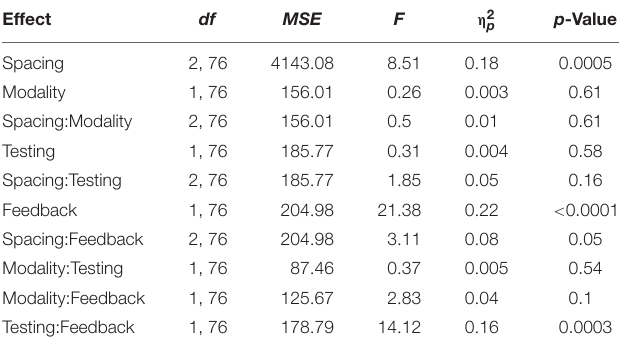
TABLE 1 | ANOVA learning principles.